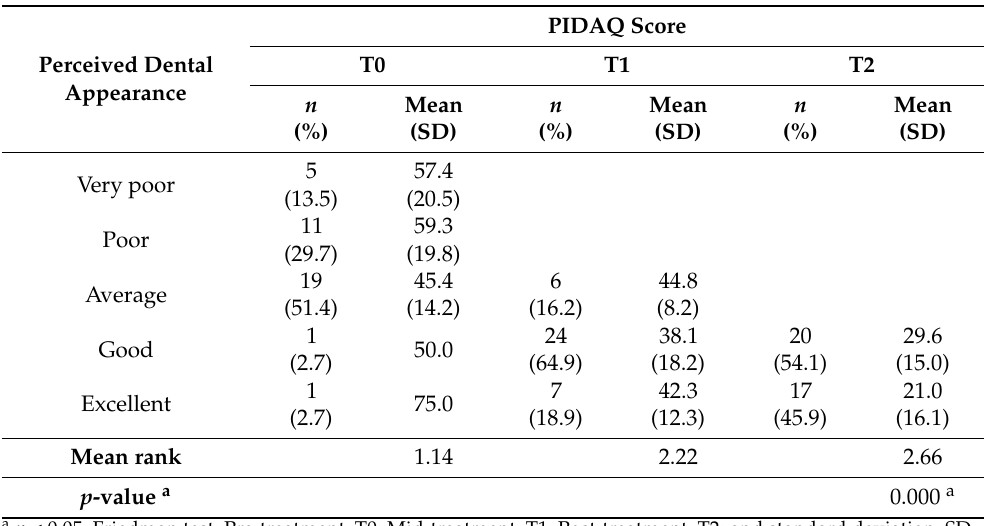
Table 4. Malaysian psychosocial impact of dental aesthetics questionnaire (PIDAQ) scores by propor- tions of perceived dental appearance from T0 to T2 ( N =